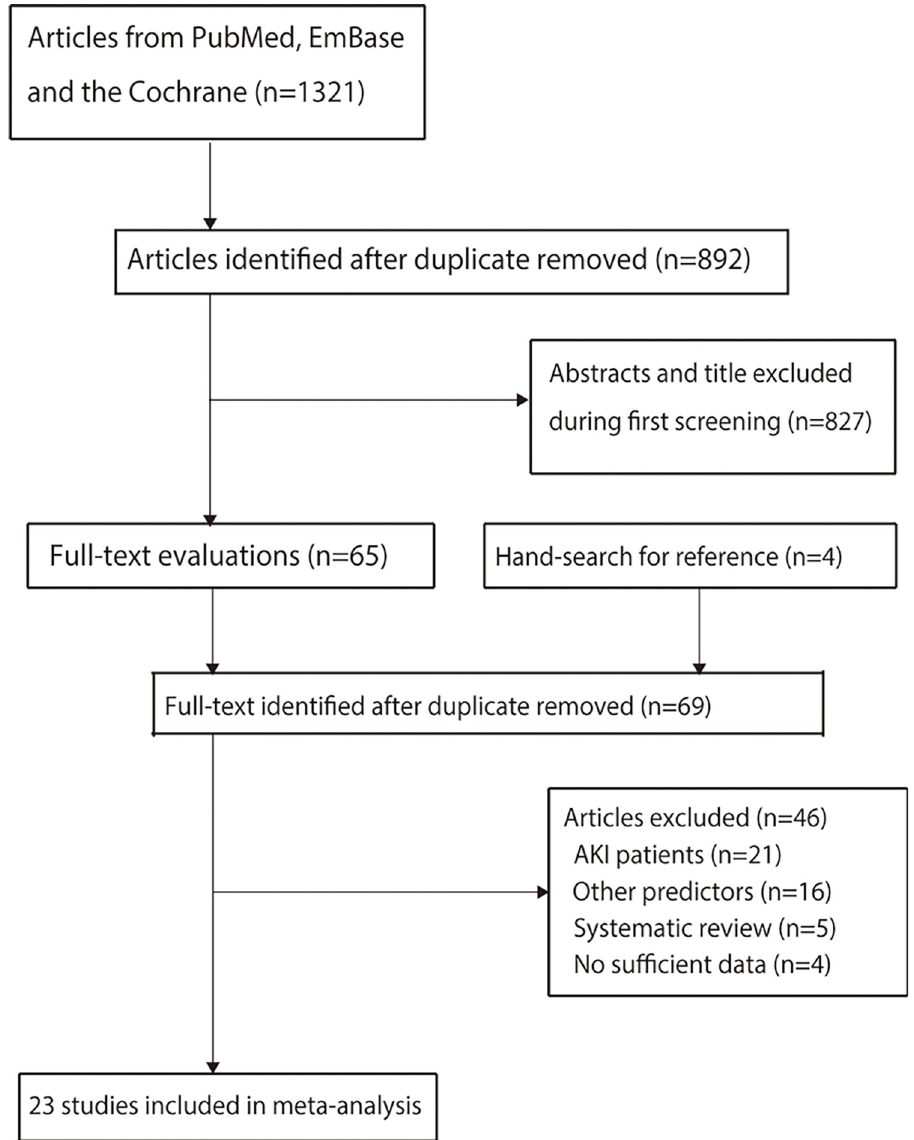
Fig 1. Flow diagram of the literature search and studies selection